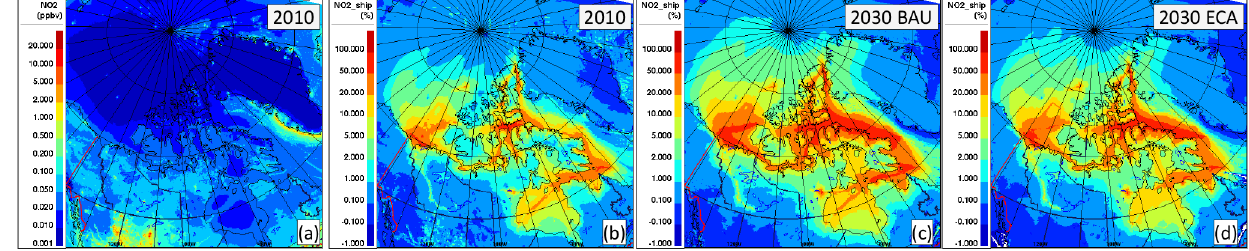
Figure 11. Modelled mean ambient NO 2 concentrations for July–August–September (shipping season) of 2010 base year (a) , and relative contribution from Canadian Arctic shipping emissions for the 2010 base year (b) , 2030 BAU (c) , and 2030 ECA (d) .